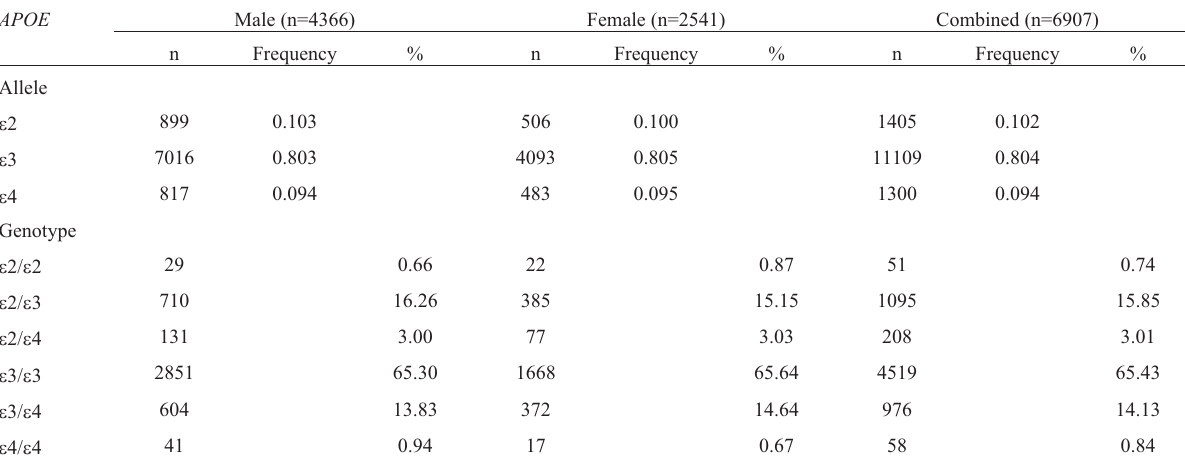
Table 1 - Allele and genotype frequencies of APOE in 6907 participants in Hakka population. APOE Male